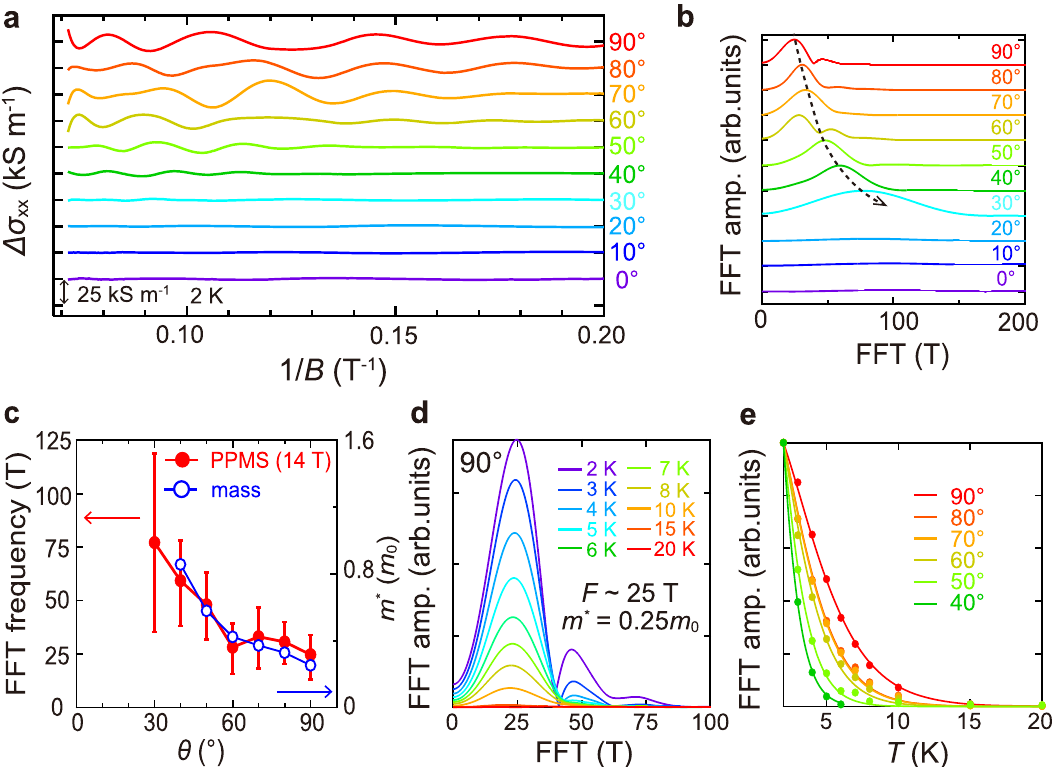
Fig. 5 Angular dependence of the SdH oscillations for the SrRuO 3 fi lm with t = 10 nm using the PPMS. a Angular dependence of the background-subtracted SdH oscillations at 2 K with B (5 T < B < 14 T) for the SrRuO 3 fi lm with t = 10 nm. b Angular dependence of the FFT spectra of SdH oscillations at 2 K for the fi lm with t = 10 nm. The dashed line is a guide for the peak shift. c Angular dependence of the FFT frequency (red fi lled circles) and the cyclotron mass (blue open circles). d Temperature dependence of the Fourier transform spectra of SdH oscillations at θ = 90° for the SrRuO 3 fi lm with t = 10 nm. e Temperature dependence of the FFT amplitude from θ = 90 – 40° for mass estimations according to the Lifshitz-Kosevich